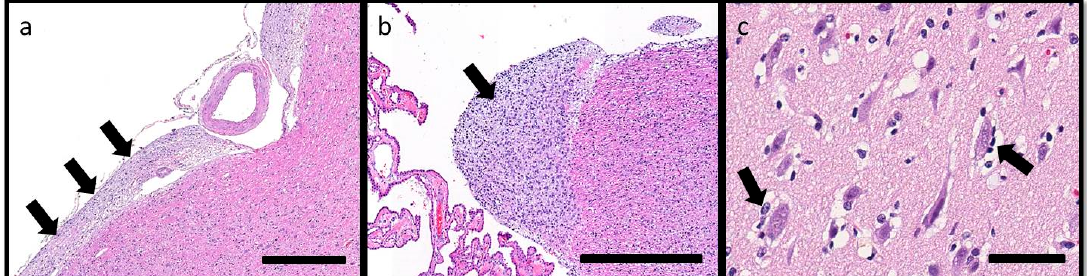
Figure 5. Secondary structures of Scherer, demonstrating migration of glioma cells through the brain, include: ( a ) subpial spread of neoplastic cells (arrows) along the ventral aspect of the brainstem, HE. Bar = 500 μ m; ( b ) subependymal aggregation (arrow), HE. Bar = 500 μ m; and ( c ) minimal perineuronal satellitosis (arrows). HE. Bar = 50 μ m.